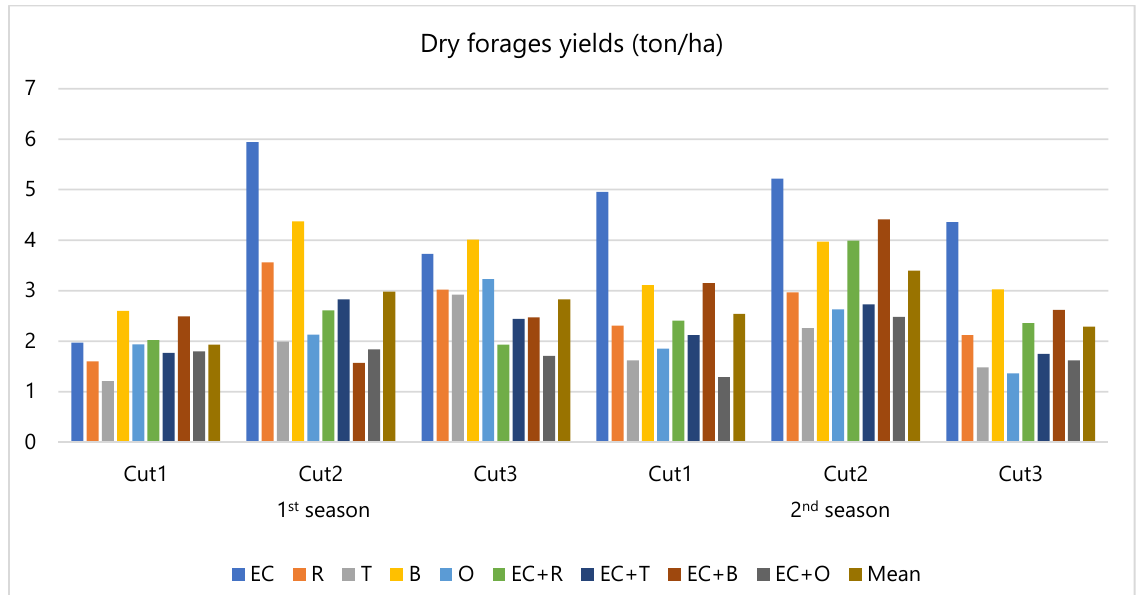
Figure 4. Means of dry forage yields (ton/ha) obtained at different cuttings of the study. EC = Egyp- tian clover monoculture, R = ryegrass monoculture, T = triticale monoculture, B = barley monoculture, O = oat monoculture, EC+R = Egyptian clover + ryegrass intercropping, EC+O = Egyptian clover + oat intercropping, EC+B = Egyptian clover + barley intercropping, and EC+T = Egyptian clover + triticale intercropping (L.S.D. forage × cutting